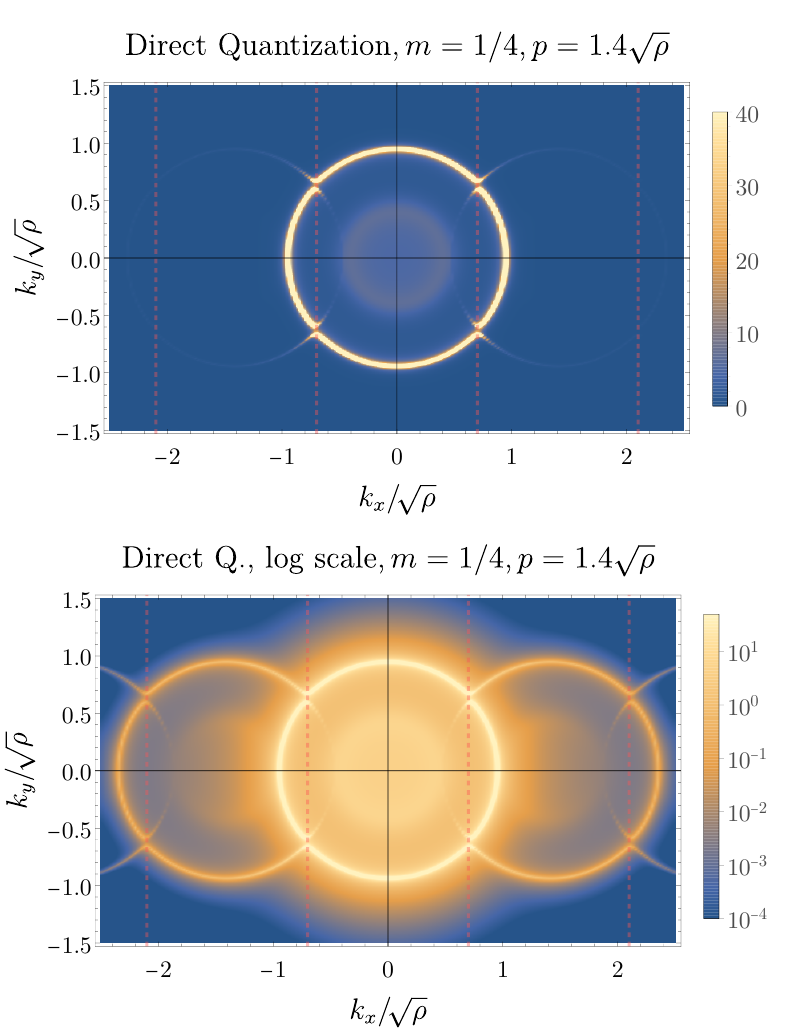
Figure 4 . The fermionic spectral density in the holographic model with weak unidirectional periodic p potential ( (cid:21) = 0 : 1 ). The density plots at small ( ! = 0 : 01 (cid:26) ) show the e(cid:11)ects of introducing the periodic potential. The two plots represent the same data on linear (upper) and logarithmic (lower) scales. Near the Brillouin zone boundary, indicated by the dashed lines, the umklapp gap is starting to open. The weak nature of the potential suppresses the intensity of the copies in neighbouring Brillouin zones, to the extent that they are hardly visible in the upper plot. The lower plot shows that the copies are clearly visible on a logarithmic scale. The background parameters are: p p p = 1 : 4 (cid:26) , (cid:21) = 0 : 1, T = 0 : 01 (cid:26) , (cid:22) 2 (cid:25) (cid:26)= 0 :